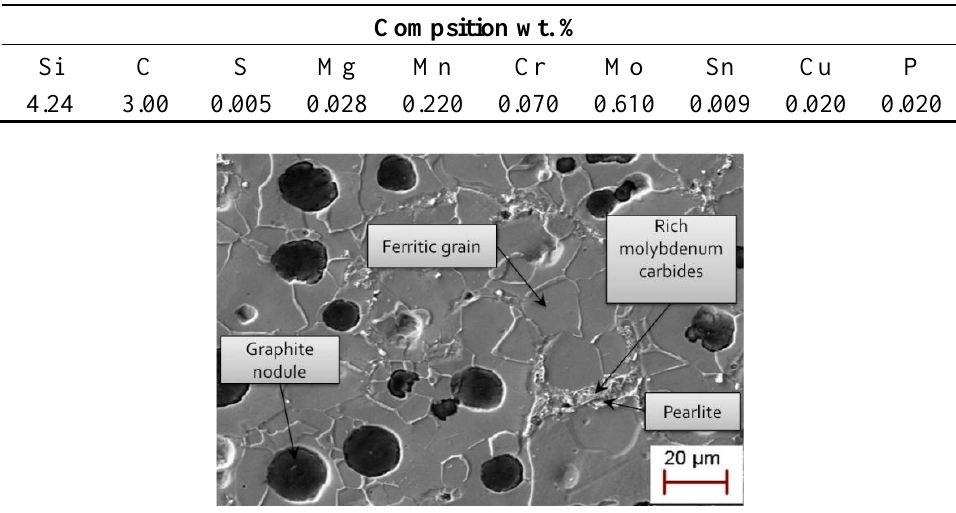
Table 1. Chemical composition in wt. % of the studied SiMo ductile cast iron (Fe: balance).